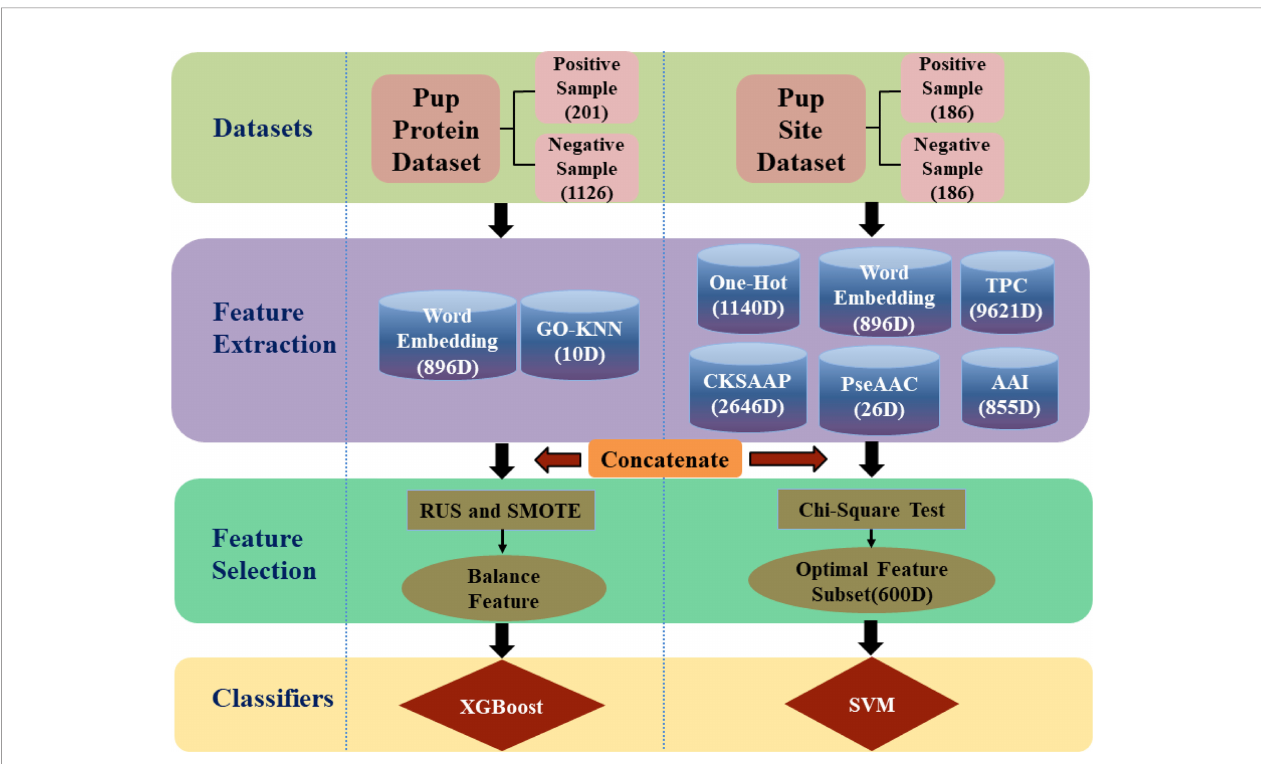
FIGURE 1 | The framework of PUP-PS-Fuse (rounded squares represent data sets, cylinders represent feature extraction methods, rectangles and ellipses represent feature selection methods, and diamonds represent classi fi ers. RUS is the abbreviation of Random Under-sampling and SMOTE is the abbreviation of Synthetic Minority